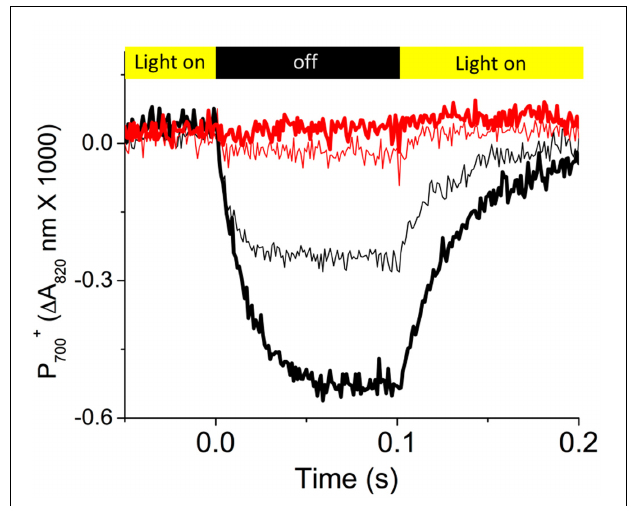
FIGURE 3 | Dark-interval relaxation kinetics reflecting the redox reactions of P 700 . Prior to the measurements, attached leaves of Col-0 (black curves) and cfq (red curves) were illuminated for at least 20 min with 300 µ mol photons · m − 2 · s − 1 at ambient (400 ppm, thin curves) and low (50 ppm, thick curves) CO 2 . Kinetics of absorbance changes were measured using the IDEASpec device as described in the text. As shown in the colored bands at the top of the graph, the actinic illumination was switched off for 100 ms time intervals starting at time zero. Data is plotted as the fraction of P 700 oxidized determined by the differences in absorbance changes at 810–940 nm, normalized to the maximum absorbance changes observed under far red illumination followed by a saturating